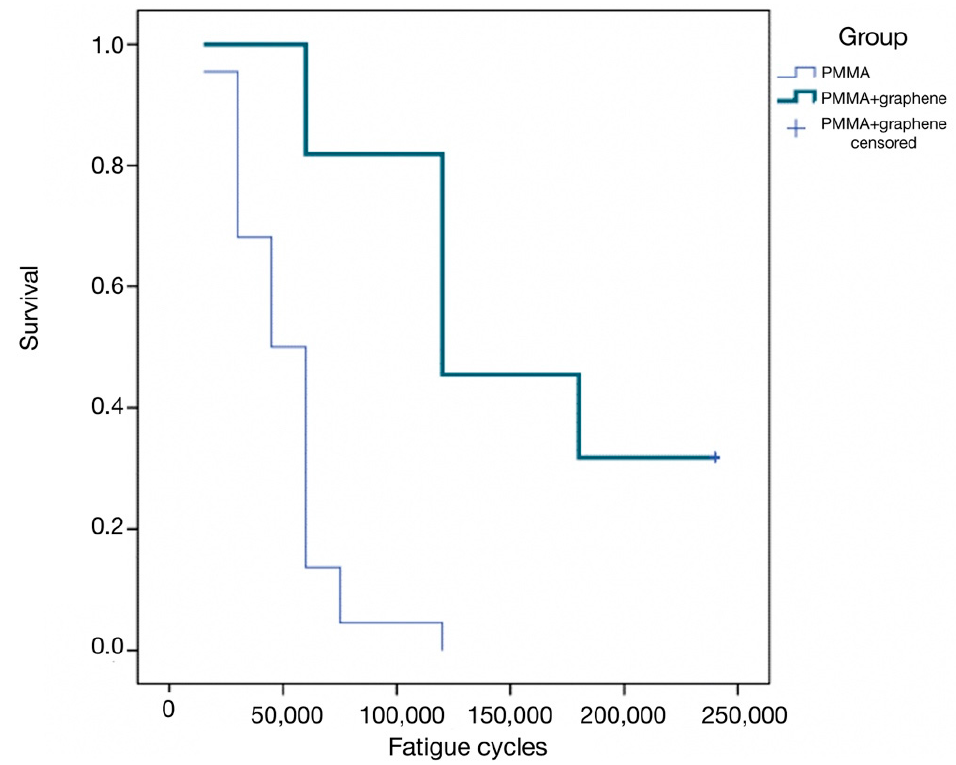
Figure 3. Kaplan–Meier survival curves corresponding to the number of loading cycles until fracture.